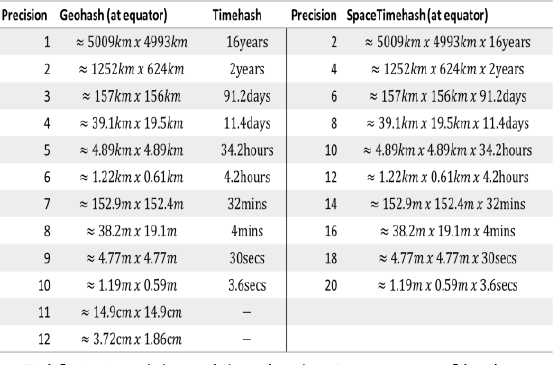
Figure 1. GeoHash – tmwg4 and each of the four images